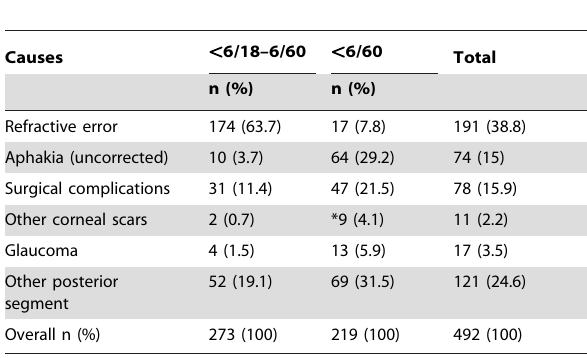
Table 3. Cause of Visual impairment and blindness stratified by category of visual impairment and